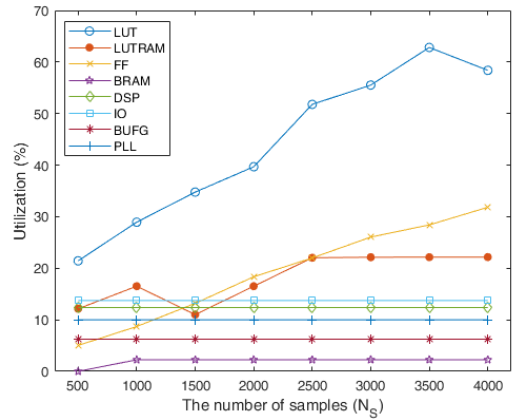
Figure 12. The utilization results of the FRMCO according to 𝑁